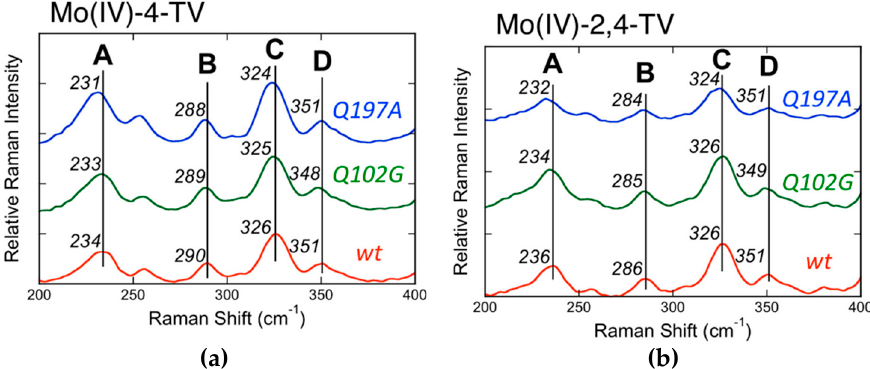
Figure 11. Low-frequency rR spectra for wt, Q102G, and Q197A XDH, Mo IV − 4-TV ( a ) and Mo IV −